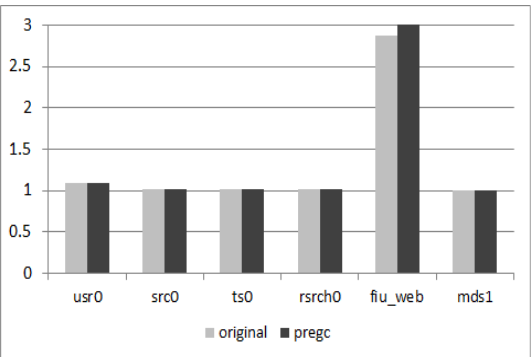
Figure 11. Write amplication contrast. The figure shows the comparison of the write amplification factor of original 3D SSDs and 3D SSDs with PreGC for different